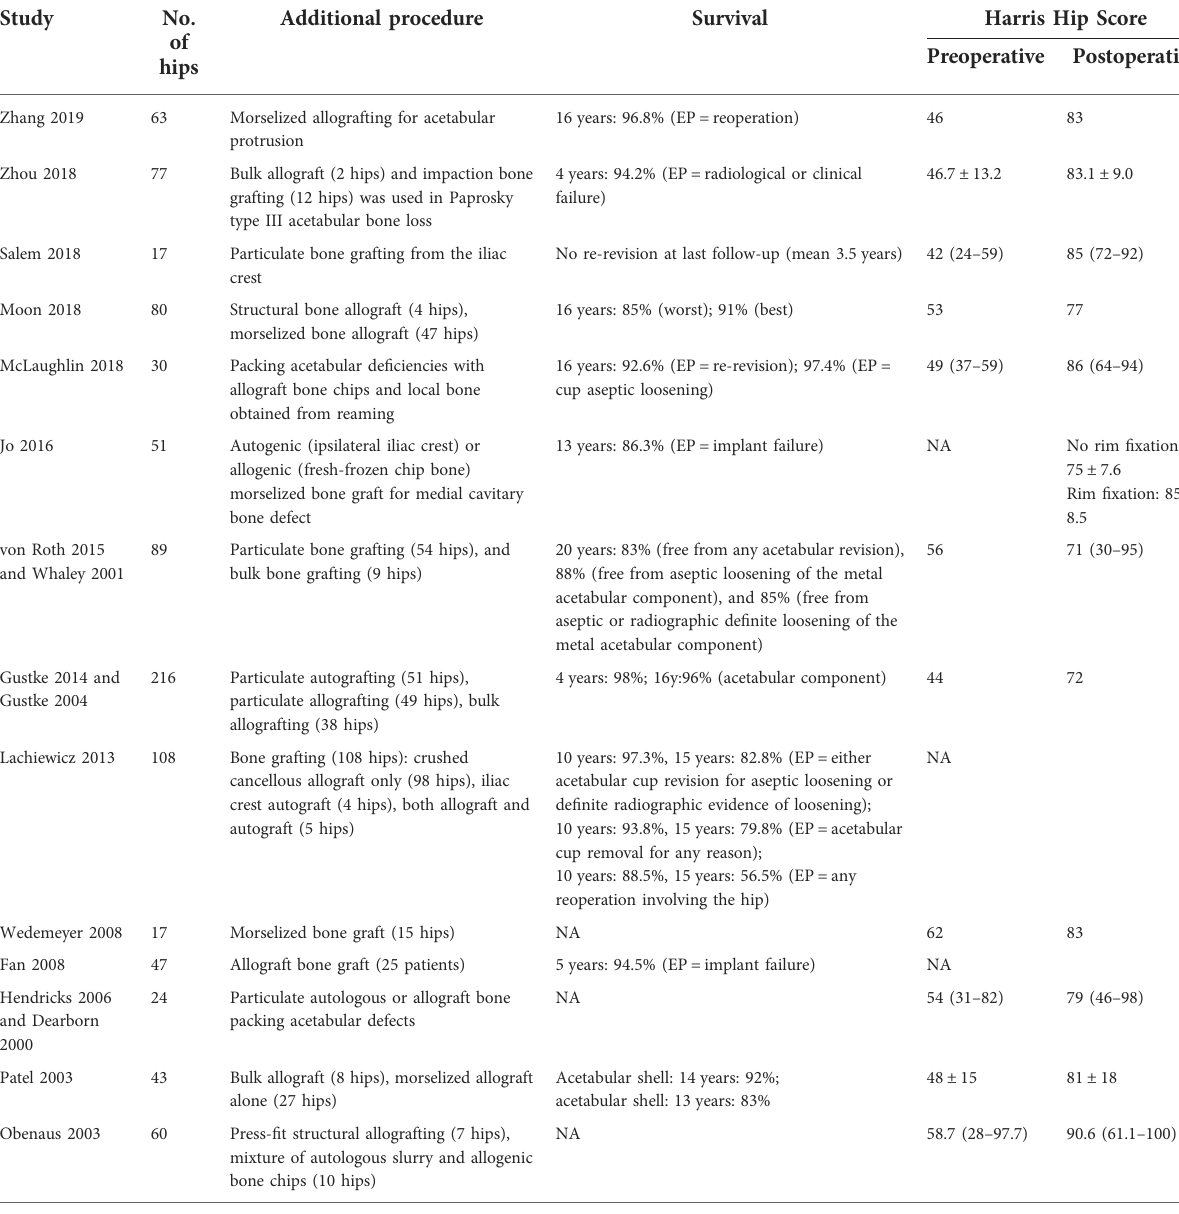
TABLE 3 Additional procedures, survival, and Harris Hip